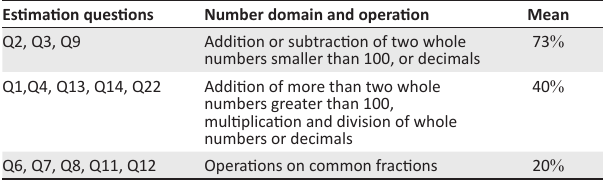
TABLE 3: Analysis of estimation questions on the number sense questionnaire. Estimation